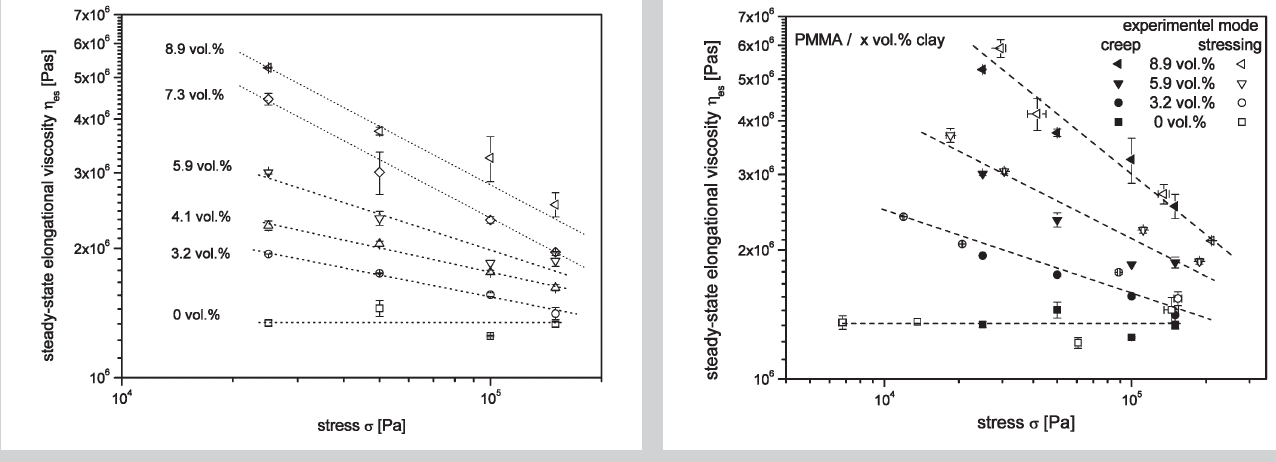
Figure 6 (left): Steady-state elongational viscosity of PMMA / nano- clay composites at 180°C (In order to guide the eye, the data points for each vol- ume fraction are connected by dotted lines). Figure 7: Steady-state elongational viscosity of PMMA / nano- clay composites at 180°C from creep experiments and calculated from stressing experiments (In order to guide the eye, the data points for each volume frac- tion are connected by dot- ted